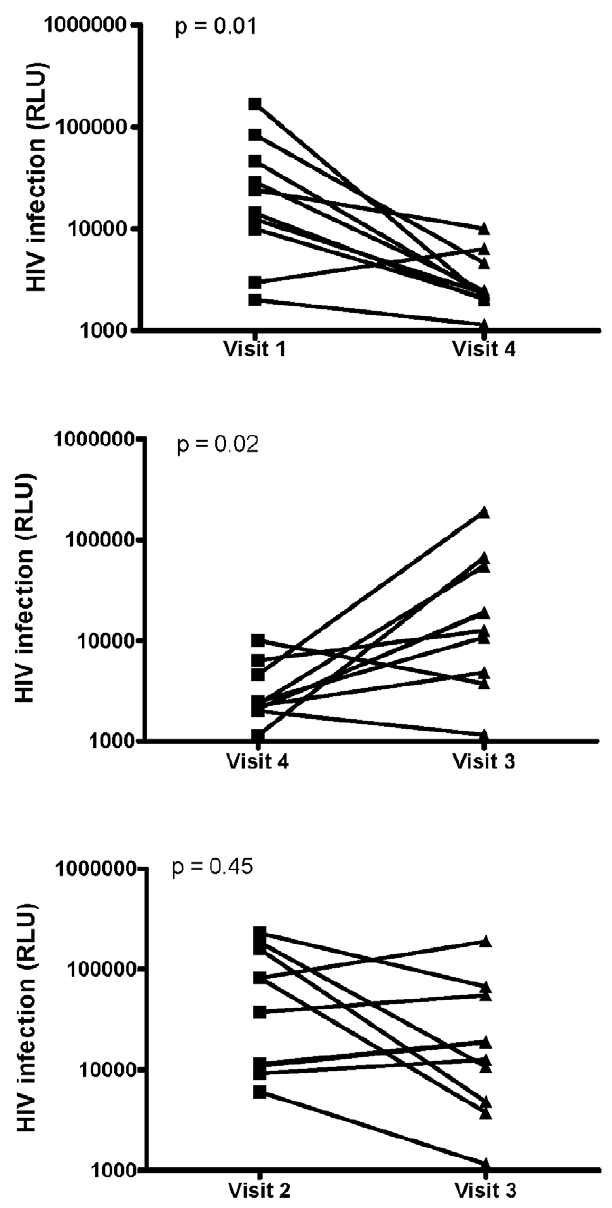
Figure 1. Loss in the anti-HIV activity in CVL collected following a single application of PRO 2000 gel in the absence or following coitus. TZM-bl indicator cells were exposed to 10 3 TCID 50 HIV-1 BaL in the presence of each CVL sample and after 48 h incubation, the cells were lysed and infection monitored by luciferase assay. Results are mean RLU obtained from 2 independent experiments, each conducted in triplicate. The upper panel shows results for each subject for Visit 1 (baseline) versus Visit 4 (post-gel), middle panel for Visit 4 (post-gel) versus Visit 3 (post-gel and postcoital) and lower panel for Visit 2 (postcoital) versus Visit 3 (post-gel and postcoital). doi:10.1371/journal.pone.0008781.g001 PLoS ONE |